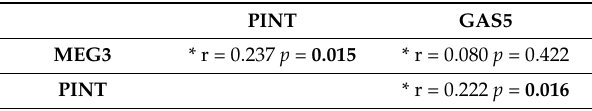
Table 3. Correlation between lncRNAs.